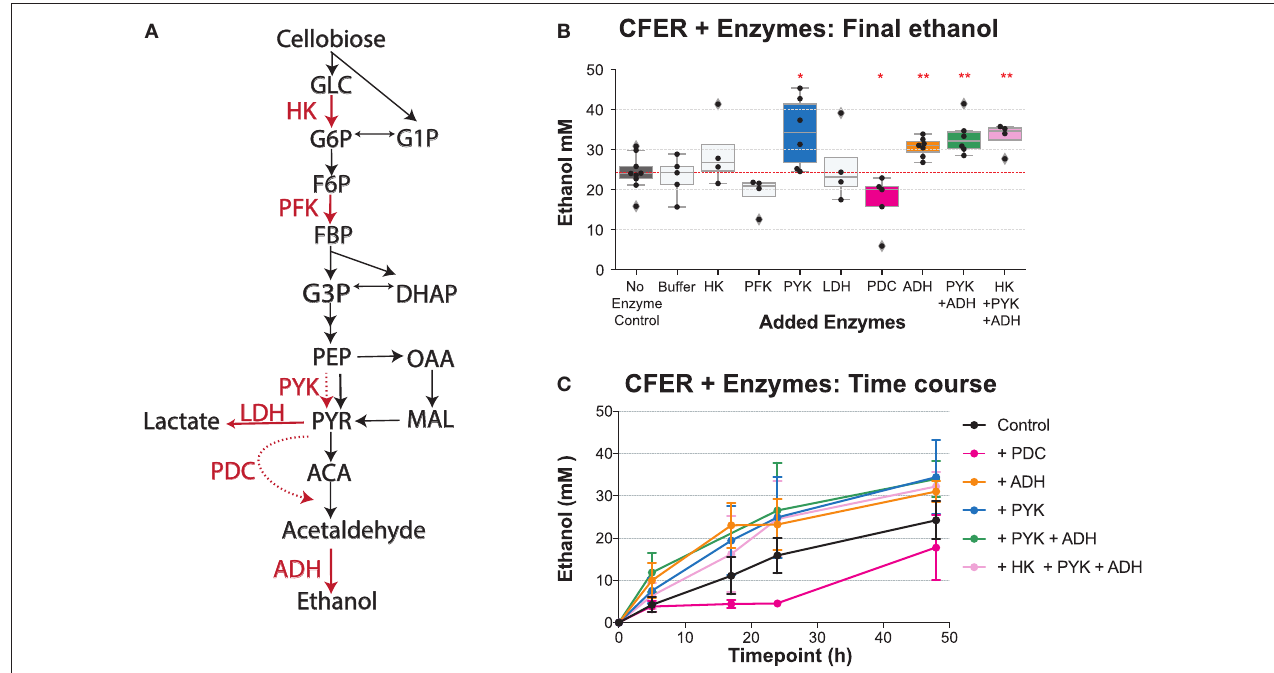
FIGURE 7 | Adding purified enzymes to the CFER. (A) The cellobiose-to-ethanol pathway is shown. Added enzymes are highlighted in red. The dashed red lines indicate a reaction that does not exist in strain LL1570. HK, hexokinase; PFK, phosphofructokinase; PYK, pyruvate kinase; LDH, lactate dehydrogenase; PDC, pyruvate decarboxylase; ADH, alcohol dehydrogenase. (B) Final ethanol production of CFER with addition of different purified enzymes. The “Buffer” sample indicates the ammonium sulfate buffer control, since PYK, LDH, and PDC enzymes were added from ammonium sulfate stocks. All added enzymes were titrated to a final concentration of 3 U/ml. Individual paired t -tests were performed to compare different groups to the CFER control with no added enzymes; * p < 0.05 and ** p < 0.01. Whiskers of the boxplot represent 1.5 × interquartile range (IQR). (C) The time course of ethanol production is shown for the subset of the reactions from (B) exhibiting significant differences in final ethanol titer. Error bars indicate 1 standard deviation ( n ≥ 4). See Figure 1 for metabolite abbreviations. Raw data included in Supplementary Table 9